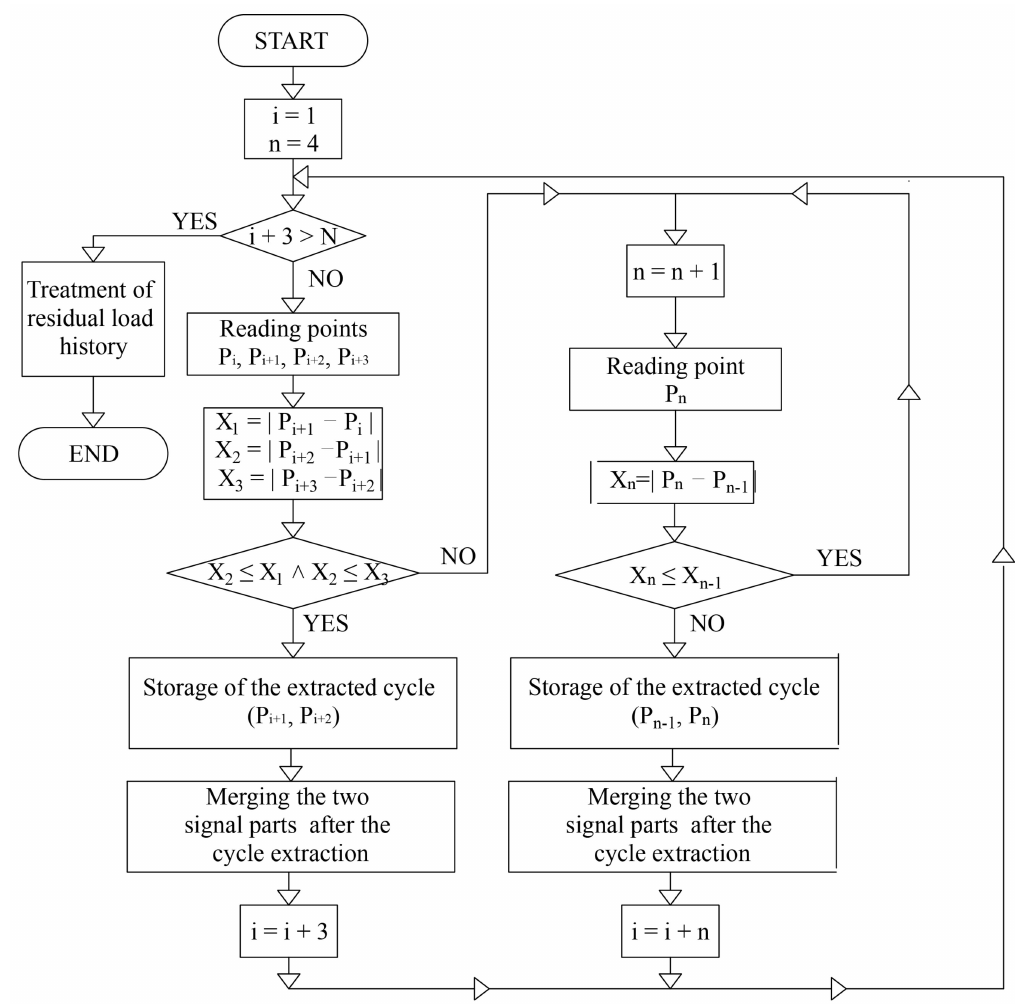
Figure 12. Rainflow method algorithm with the n-points